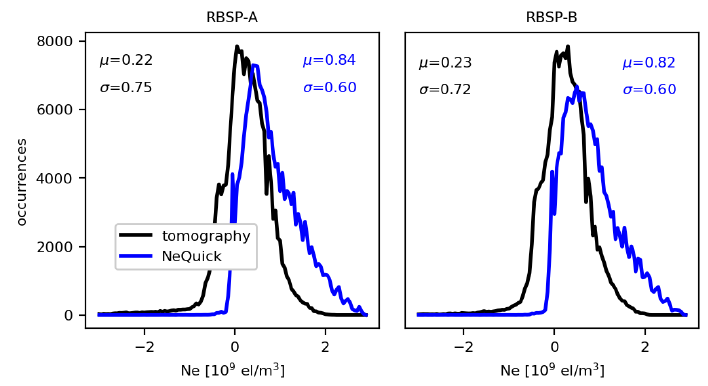
Figure 14. Histogram of the electron density error for tomography (black line) and NeQuick (blue line) when compared to Van Allen Probes estimations for 2013. The graph also shows the total mean ( µ ) error and standard deviation ( σ ) of the